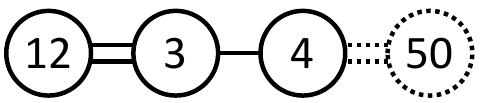
Figure 9 . Dynkin diagram of the B 3 = so(7) algebra. The number in circles corresponds to the generator of the Weyl symmetry or its product. If we restrict ourselves to C B , s 5 s 0 can be generated by s 1 s 2 , s 3 and s 4 as in